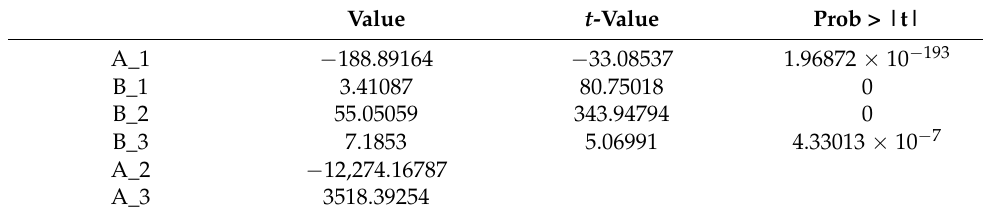
Table 7. Test parameters for significance of fitting curve (red curve) of Figure